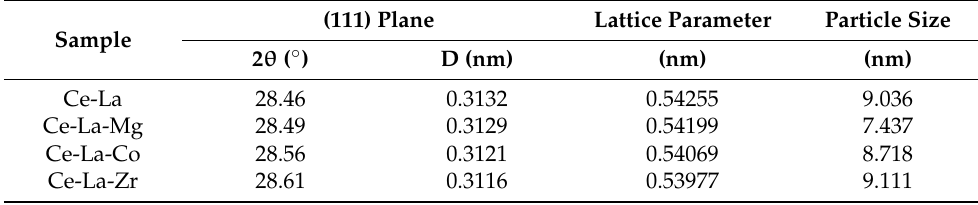
Table 1. Structural and textural properties of Ce-La-M solid solution.